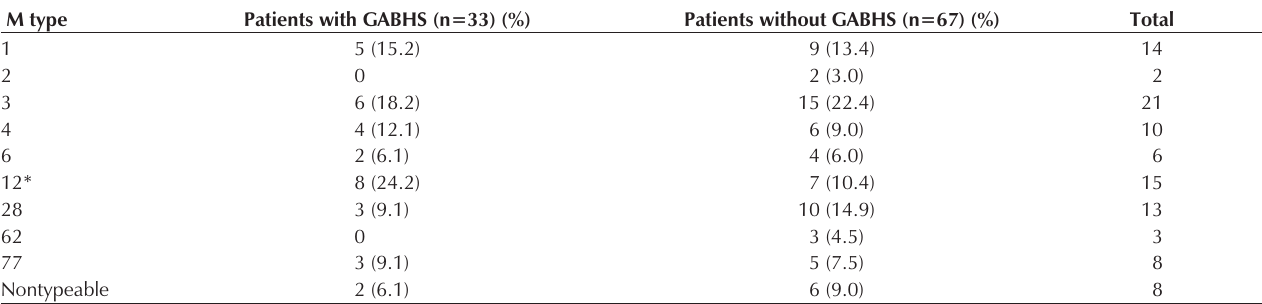
Group A beta-hemolytic streptococcus (GABHS) M type by bacteriological outcome